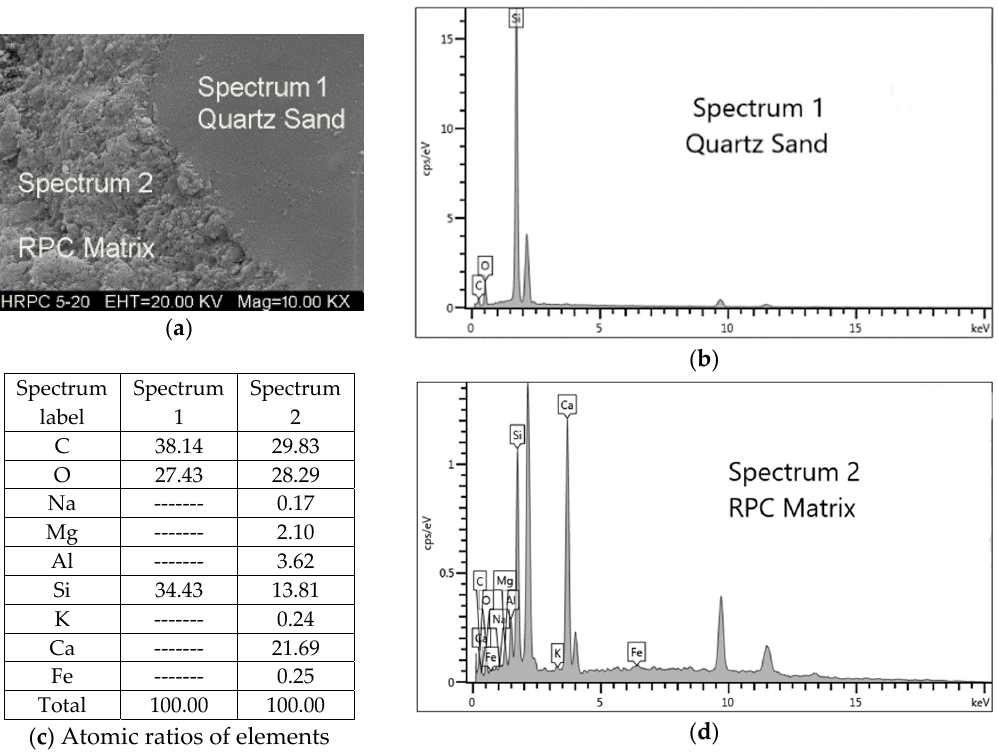
Figure 21. SEM micrographs of the bonding interface between quartz sand and RPC matrix at room temperature.